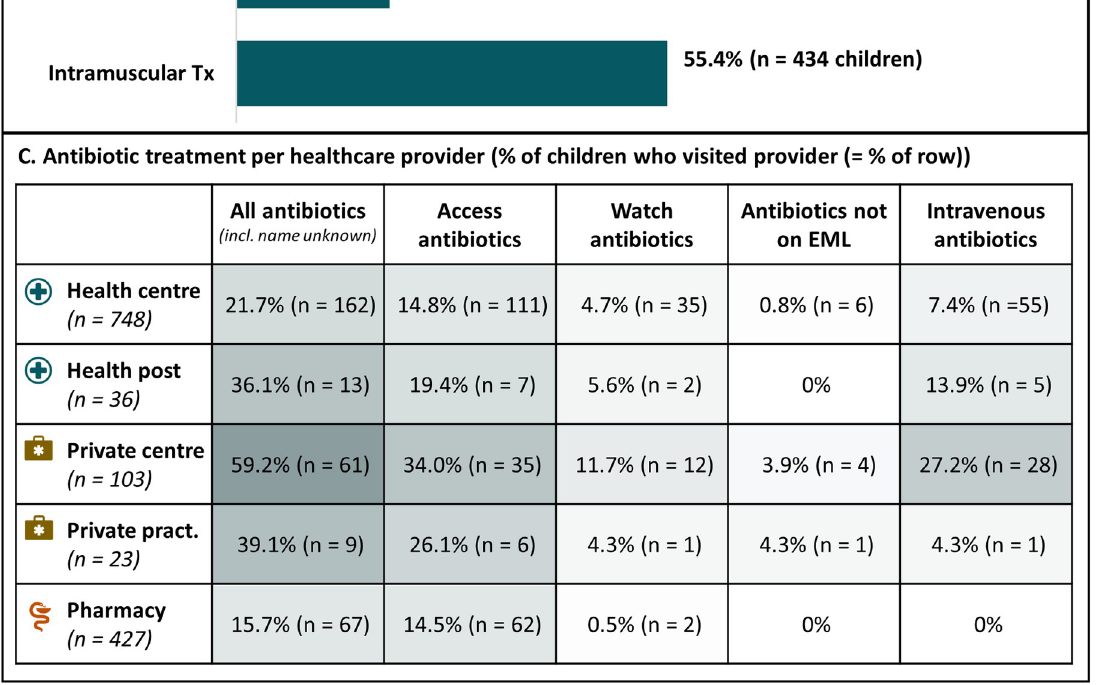
Fig 5. Overview of prehospital patient management of children under-five admitted to Kisantu hospital with severe febrile illness (n = 784). Panel A : Proportion of enrolled children who received at least once the respective class of prehospital care. Panel B : Proportion of enrolled children who had at least one overnight stay, diagnostic (dx) blood test or intravenous/intramuscular treatment (Tx). Panel C : Proportion of children who visited the respective provider and received antibiotics, classified according to the national Essential Medicines List (EML) if the name of the antibiotic was known by the caretaker.